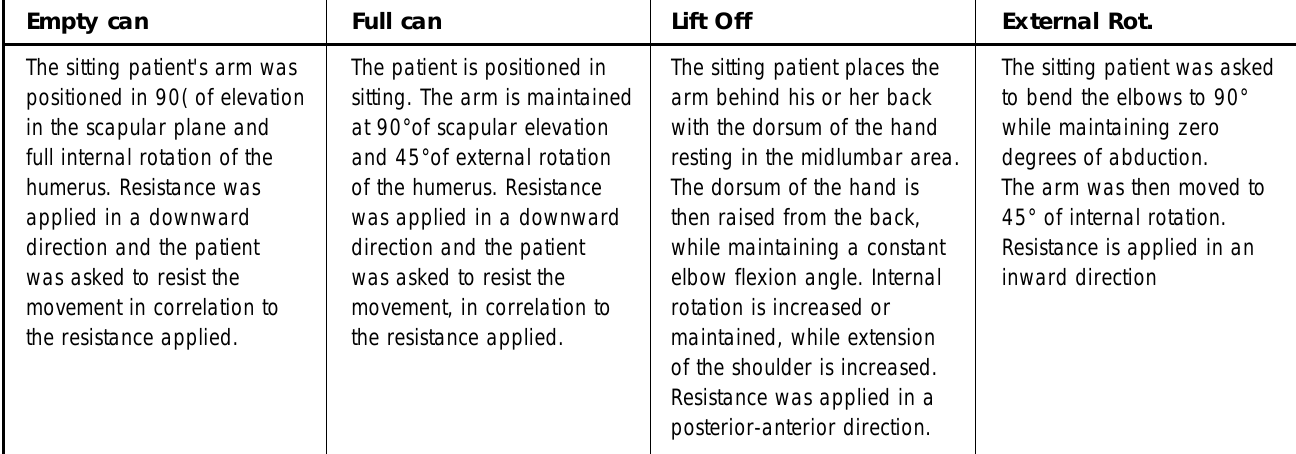
Table 1: Rotator cuff muscle tests adapted from Kelly et al. (1996) and Itoi et al. (1999).